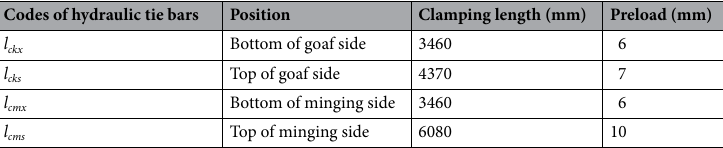
Table 2. Related parameters of hydraulic pull